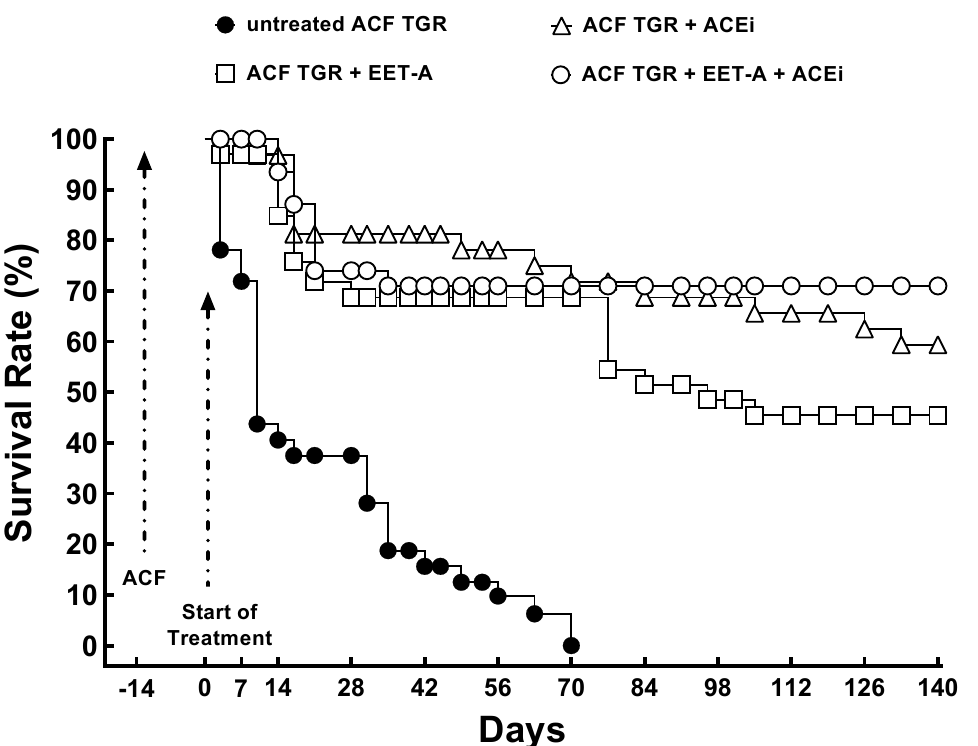
Figure 2. Assessment of the effects of treatment on the survival rate. The survival rate in sham-operated transgene-negative Hannover Sprague-Dawley (HanSD), sham-operated heterozygous Ren-2 transgenic rats (TGR), and TGR rats with aorto-caval fistula (ACF) two weeks after the creation of ACF or sham-operation, treated either with angiotensin-converting enzyme inhibitor (ACEi) alone or with 14,15-epoxyeicosatrienoic acid analog (EET-A) alone or with the combination of EET-A and